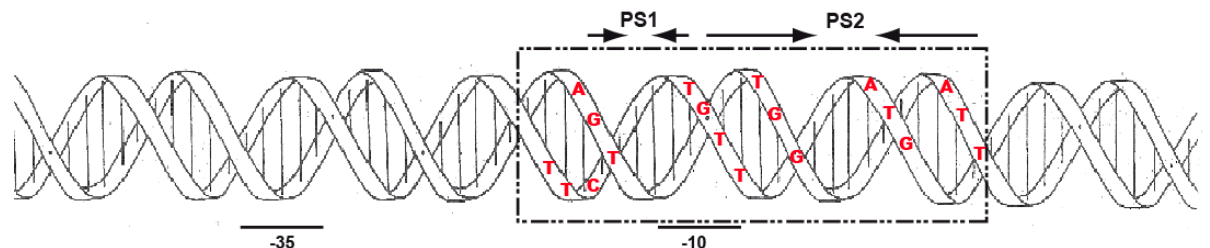
Figure 6. Summary of the footprints generated by the RelB:RelE protein complex on the DNA surrounding the P relBE promoter region. The DNA region is shown as having 10.5 bp per helical turn [58,59]. The dashed square represents the DNase I footprints, whereas the red letters are the bases whose deoxyriboses are protected by the protein from the OH · radicals. The relative positions of the − 35 and − 10 regions are indicated by a horizontal solid line, whereas the two palindromic sequences, PS1 and PS2, are indicated by arrows with the arrowheads pointing to the symmetry center.